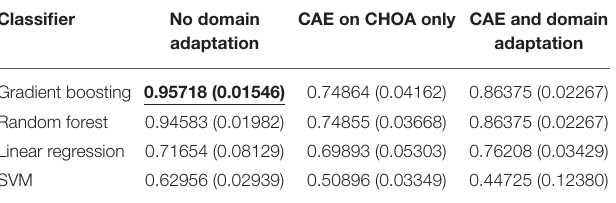
TABLE 4 | Mortality prediction results on and Children’s Healthcare of Atlanta (CHOA) data (both temporal and non-temporal features) under three different experimental settings.